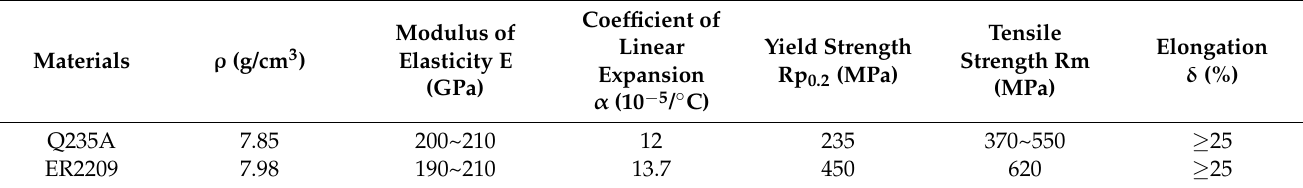
Table 2. Main physical and mechanical properties of base metal and welding